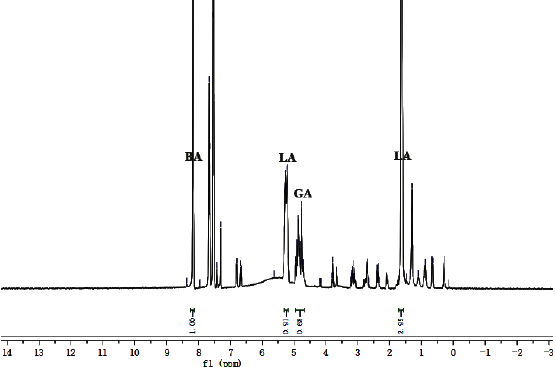
Figure 2. The 1 H NMR of Vivitrol ® . The response peaks of LA in PLGA appeared at about 1.5 and 5.2 ppm, corresponding to the -CH 3 and -CH groups. The response peaks of GA appeared at 4.7 ppm, corresponding to the -CH 2 group. LA: lactic acid, GA: glycolic acid, BA: Benzyl alcohol.